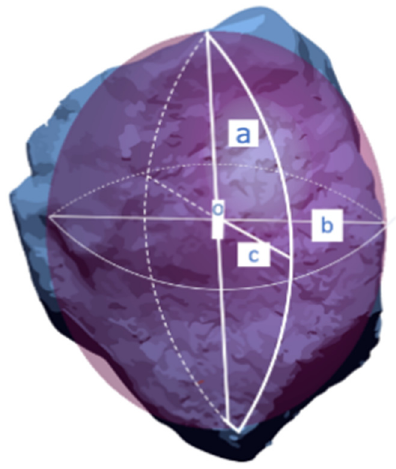
Figure 1. Schematic diagram of fitting ellipsoid model.